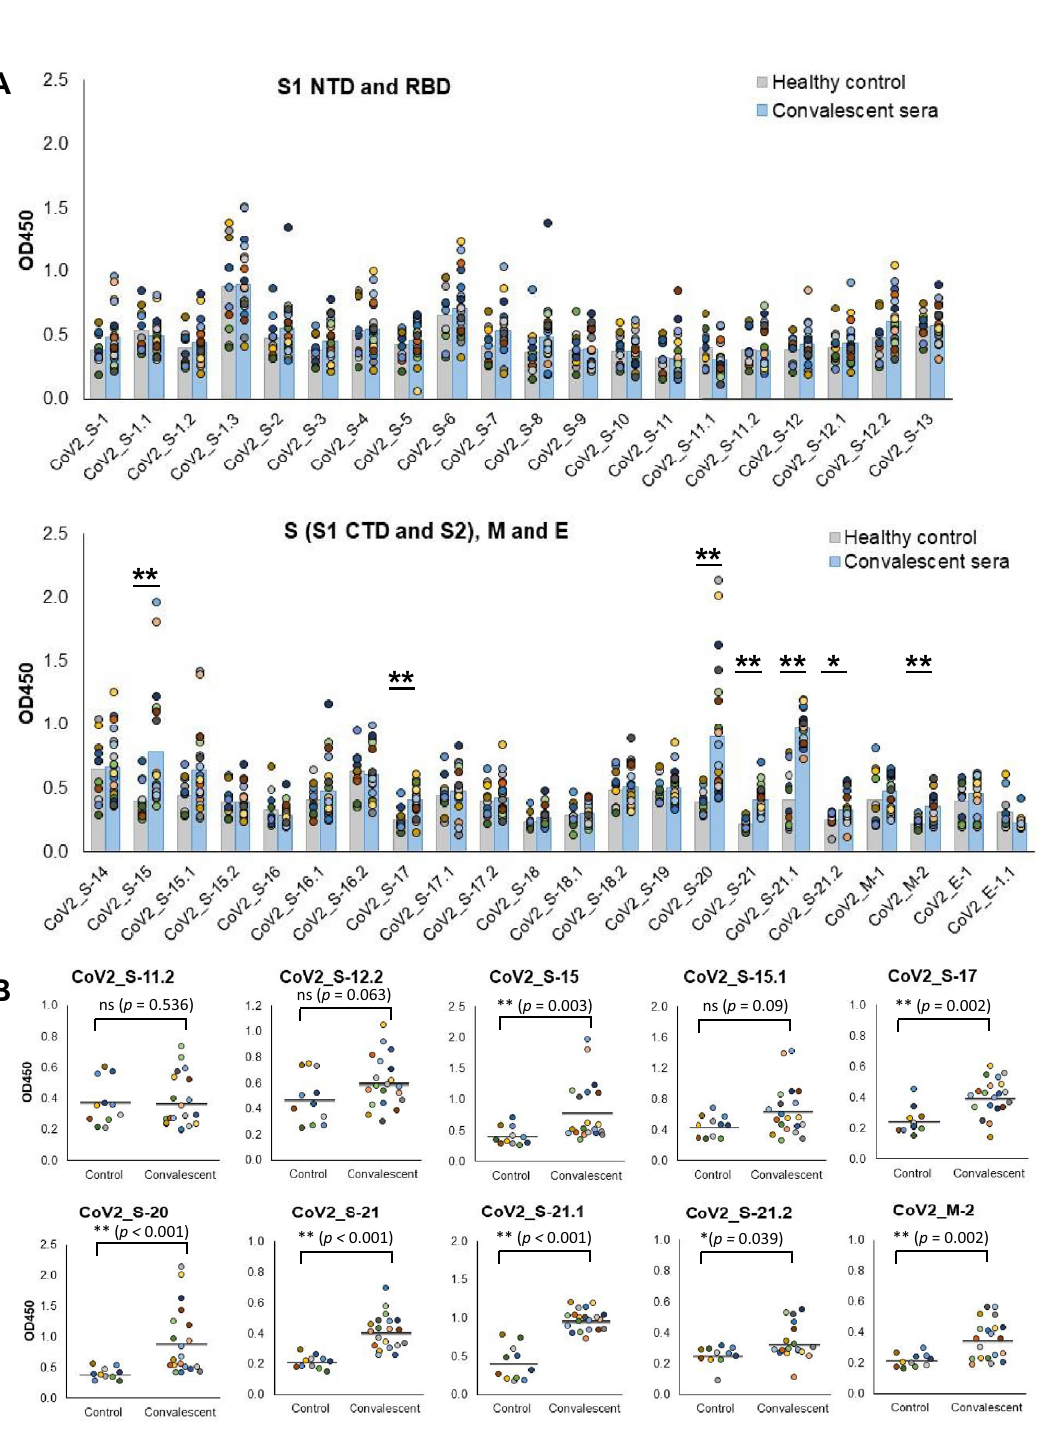
Figure 6. Antibody responses against the predicted B cell epitopes in COVID-19 convalescent sera. Peptides with the sequence corresponding to the predicted linear B cell epitopes were tested with 20 convalescent serum samples and 11 serum samples from healthy individuals using ELISA. ( A ) Antibody responses against each predicted B cell epitope on the S, M and E proteins. Antibody responses in healthy control sera and convalescent sera were compared and statically tested using non-parametric Mann–Whitney test. “*” and “**” represent a significant difference between the two groups with p -value < 0.05 and < 0.001, respectively. ( B ) Antibody responses against epitopes CoV2_S-11.2 and CoV2_S-12.2 located within the RBD and immunodominant epitopes. Antibody response in individual serum and the result of statistical analysis are shown. ns: not significant ( p >